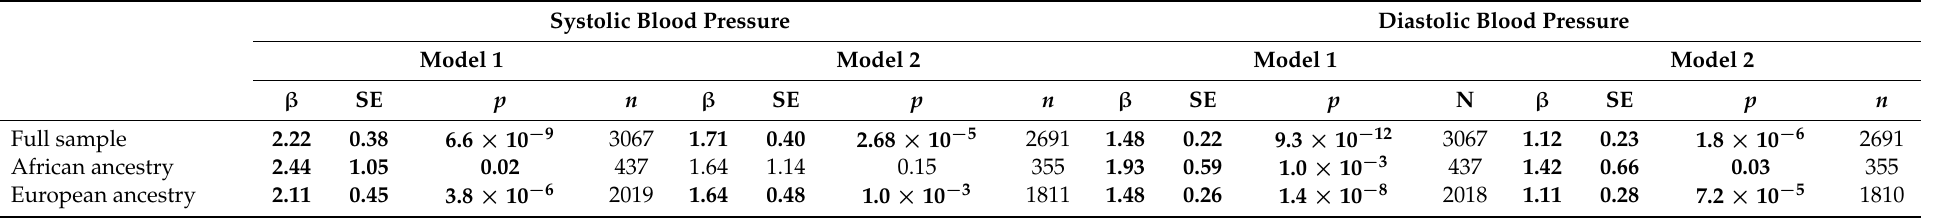
Table 3. Associations between methylation risk scores and blood pressure in the full sample and by ancestry in the Health and Retirement Study.